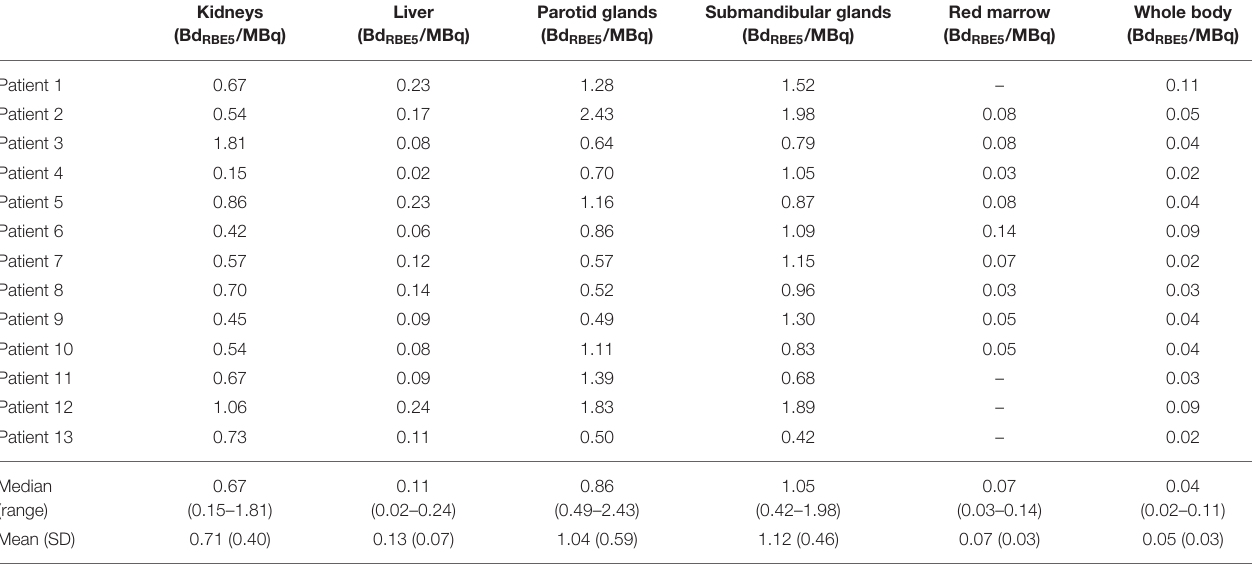
TABLE 1 | Results of 225 Ac-PSMA predictive dosimetric study in terms of Bd RBE5 /MBq (11).